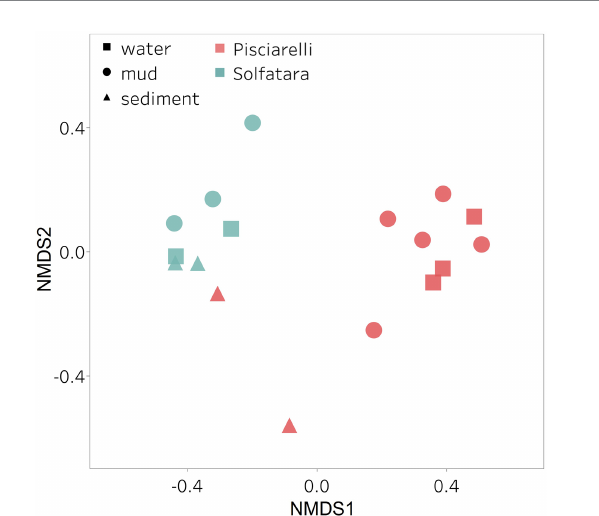
FIGURE 7 Nonmetric Dimensional Scaling (NMDS) ordination based on